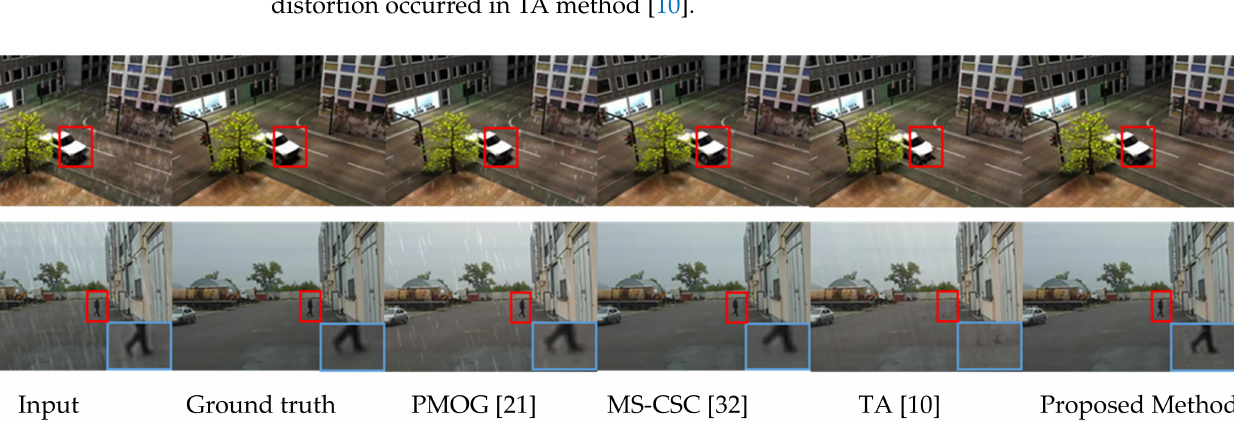
Figure 14. Comparison of the results of different methods (see the red and blue rectangle area closely) for the synthetic-rain video sequences “Truck” (1st row), and “Park” (2nd row),